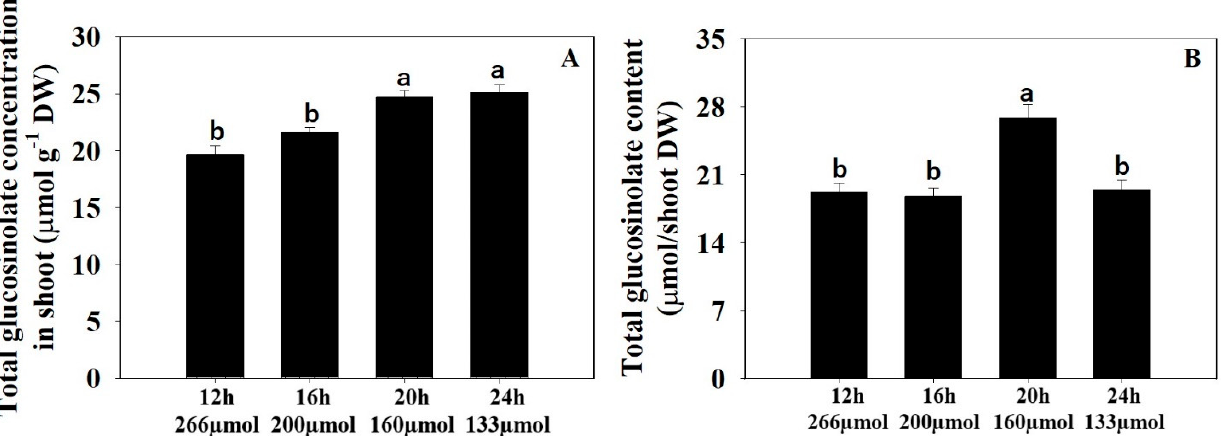
Figure 3. The glucosinolate concentration ( A ) and content ( B ) in watercress shoots under different lighting treatments of 12 h—266 µmol . m − 2. s − 1 , 16 h—200 µmol . m − 2. s − 1 , 20 h—160 µmol . m − 2. s − 1 , and 24 h—133 µmol . m − 2. s − 1 . Different letters above bars show significant differences at p ≤ 0.05, using Tukey’s multiple range test ( n = 3).